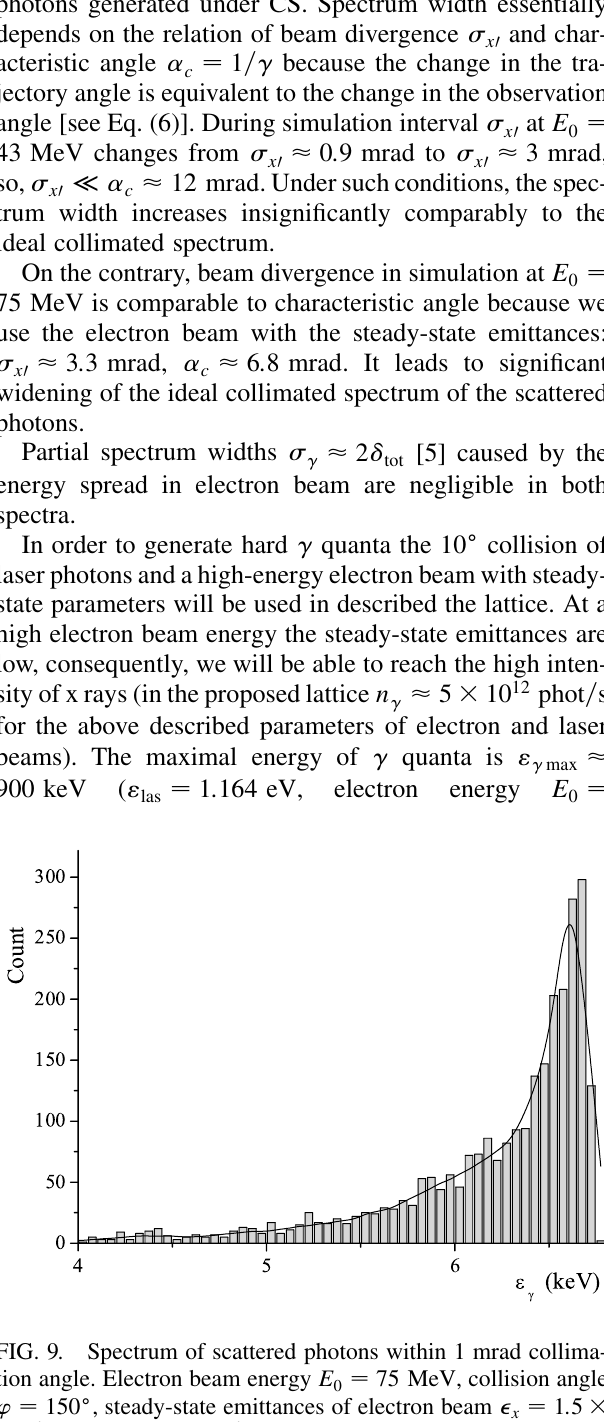
(cid:1) 75 MeV , collision angle 0 (cid:1) 1 : 5 (cid:14) x